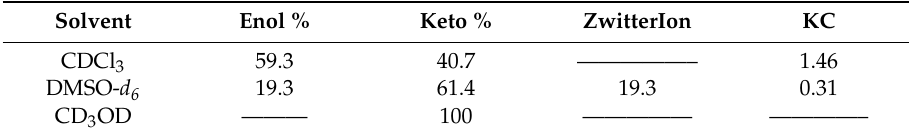
The keto-enol percentage and equilibrium constant of Compound 3 in di ff erent solvent polarities.